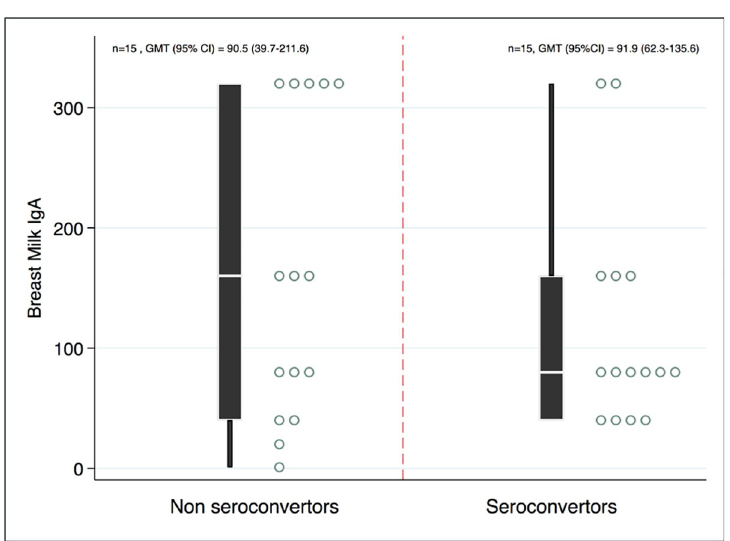
Fig 4. Distribution of rotavirus specific breastmilk IgA titers by seroconversion status.